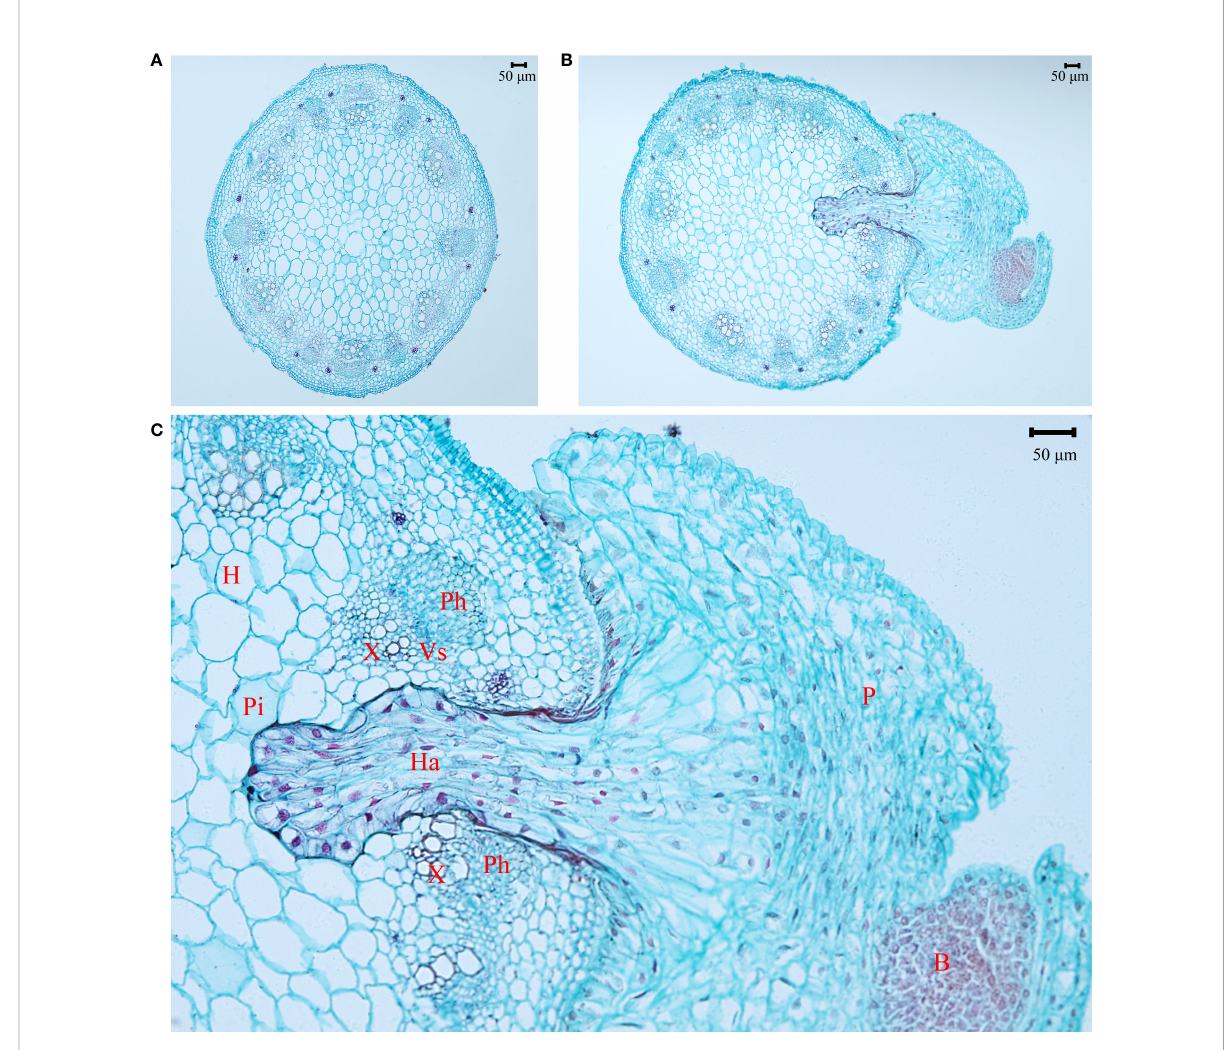
FIGURE 6 Anatomical structure of Ambrosia tri fi da stems uninfected (A) and infected (B) by Cuscuta japonica , and the magni fi ed area of haustorial endophyte (C) in the host stem. Haustorium (Ha) of the parasite (P) penetrated into and reached pith (Pi) of the host stem (H). Ph, phloem; X, xylem; Vs, vascular stripe; B, bud. Bar = 50 m